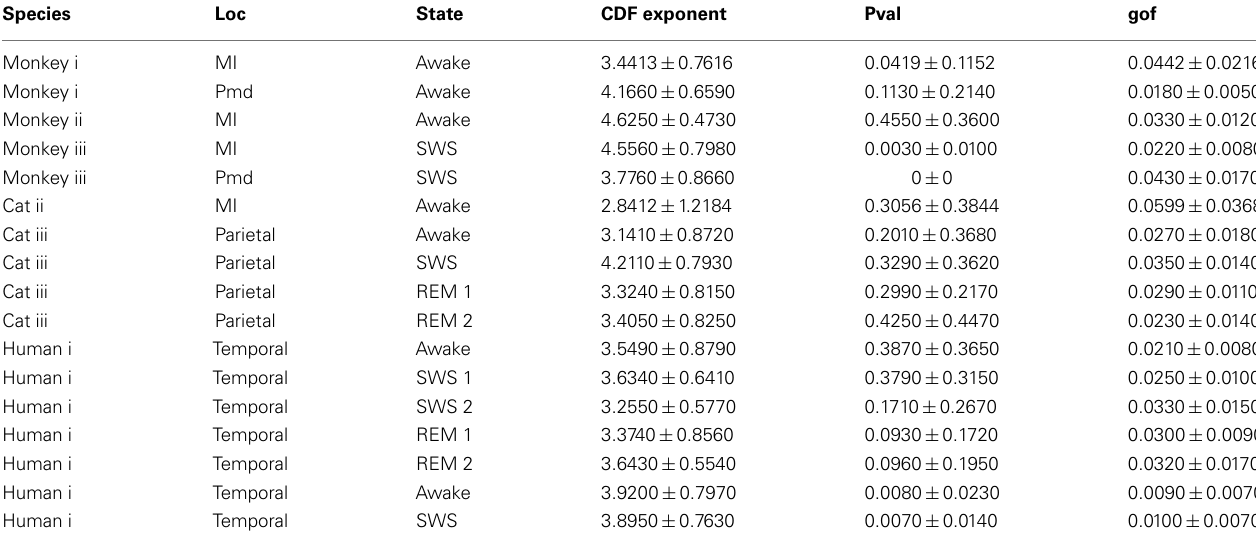
Table 1 | Summary spike